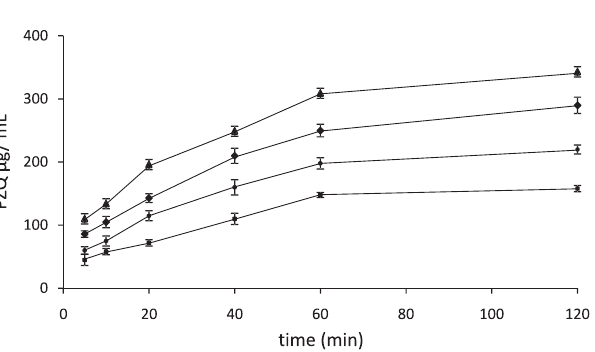
FIGURE 4 - Kinetics of the flow of PZQ within the inverted intestinal sac. PZQ pure (  ), DS PZQ-CR60 1:2, fusion method (  ); DS PZQ-CR60 1:2, co-precipitation method (  ); physical mixture PZQ-CR60 1:2 (  ). Each point represents the mean ± standard deviation,